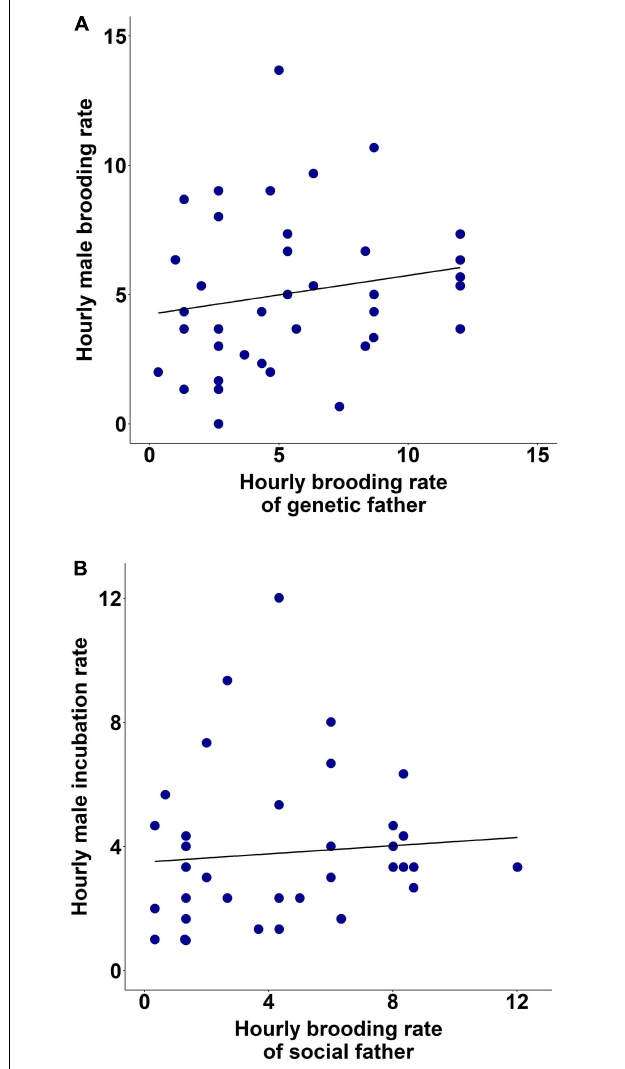
FIGURE 3 | Hourly brooding rate (A) and incubation rate (B) of male zebra finches based on hourly brooding rate of their genetic and social father,